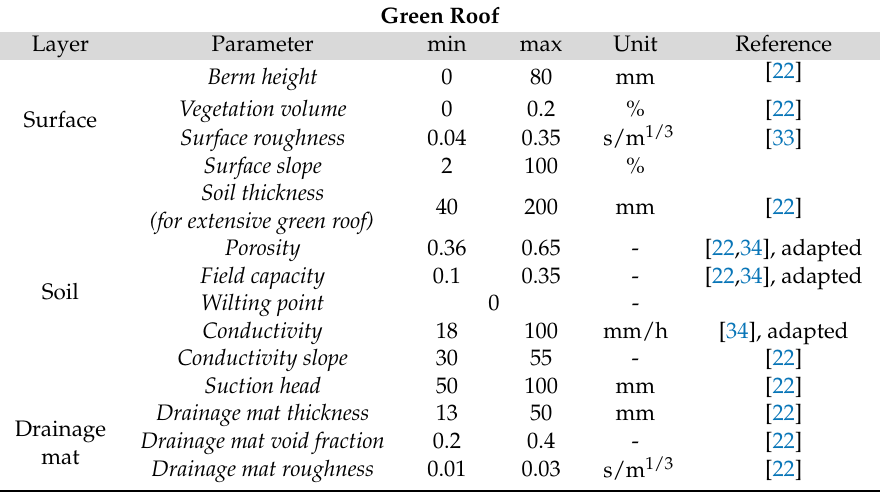
Table 1. Low impact development (LID) parameter ranges for the sensitivity